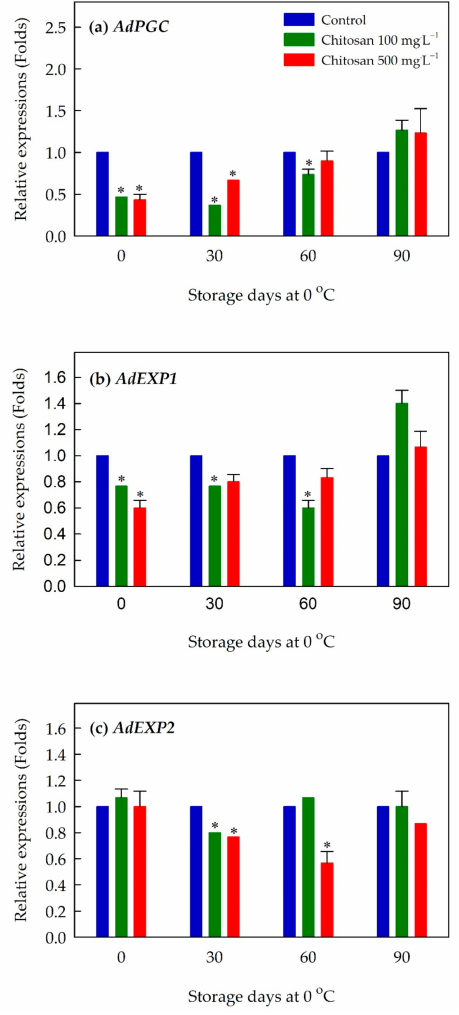
Figure 5. Effects of preharvest chitosan application on relative expression of cell wall-modification genes ( a ) AdPGC , ( b ) AdEXP1 , and ( c ) AdEXP2 during cold storage in ‘Garmrok’ kiwifruit. Vertical bars indicate SE with n = 3. Actin gene was used as internal control and the quantitative RT-PCR data were analyzed using the 2 − ∆∆ CT method. * Statistical difference caused by chitosan treatment was compared to untreated fruit (control) of each sampling date ( p ≤